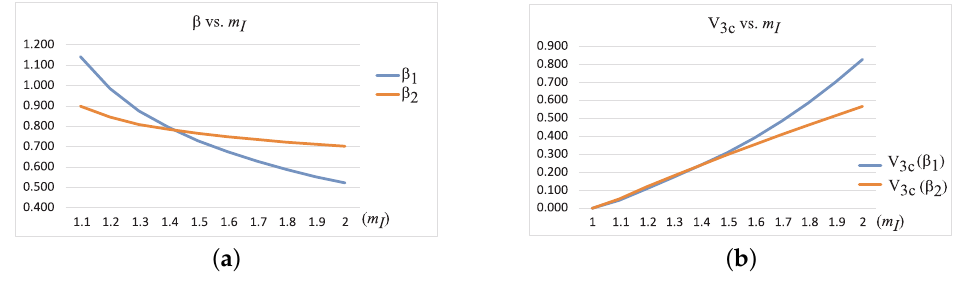
Figure 6. ( a ) Angle β vs. m I and ( b ) V 3 c vs. m I